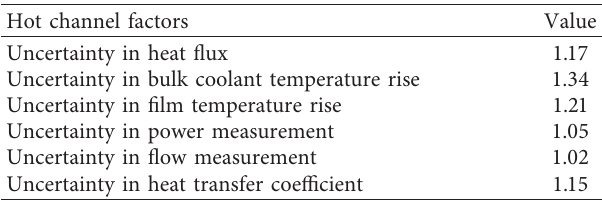
Table 2: Hot channel factors in thermal hydraulic analysis of the